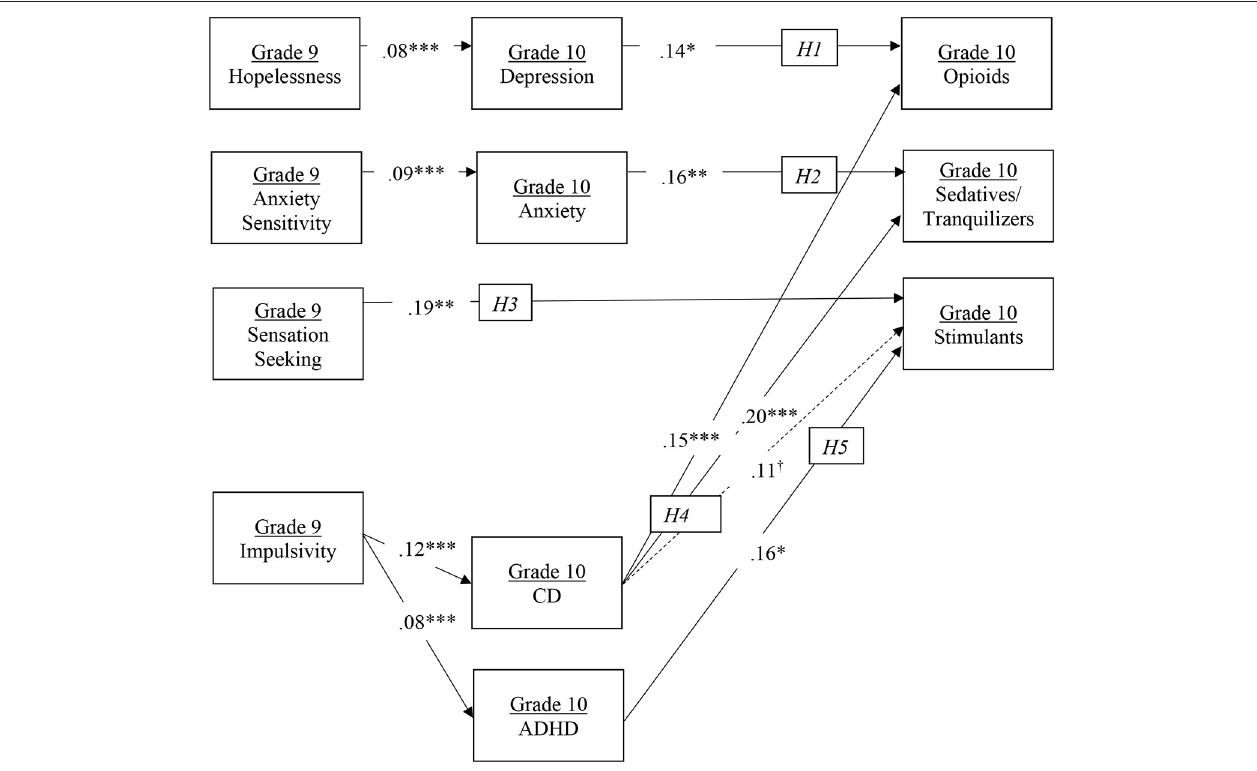
FIGURE 1 | Model results. H1-H5 represent numbered hypotheses. Solid arrows represent statistically significant hypothesized pathways; dotted arrows represent hypothesized but non-significant pathways. Numbers represent standardized coefficients. * p < 0.05, ** p < 0.01, *** p < 0.001. p = 0.06.